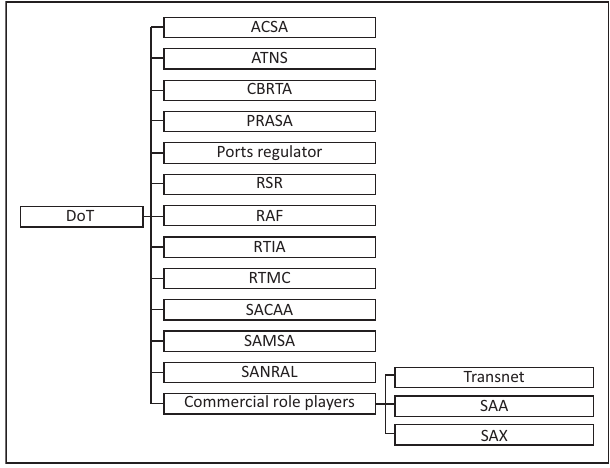
FIGURE 3: National public entities reporting to the Department of